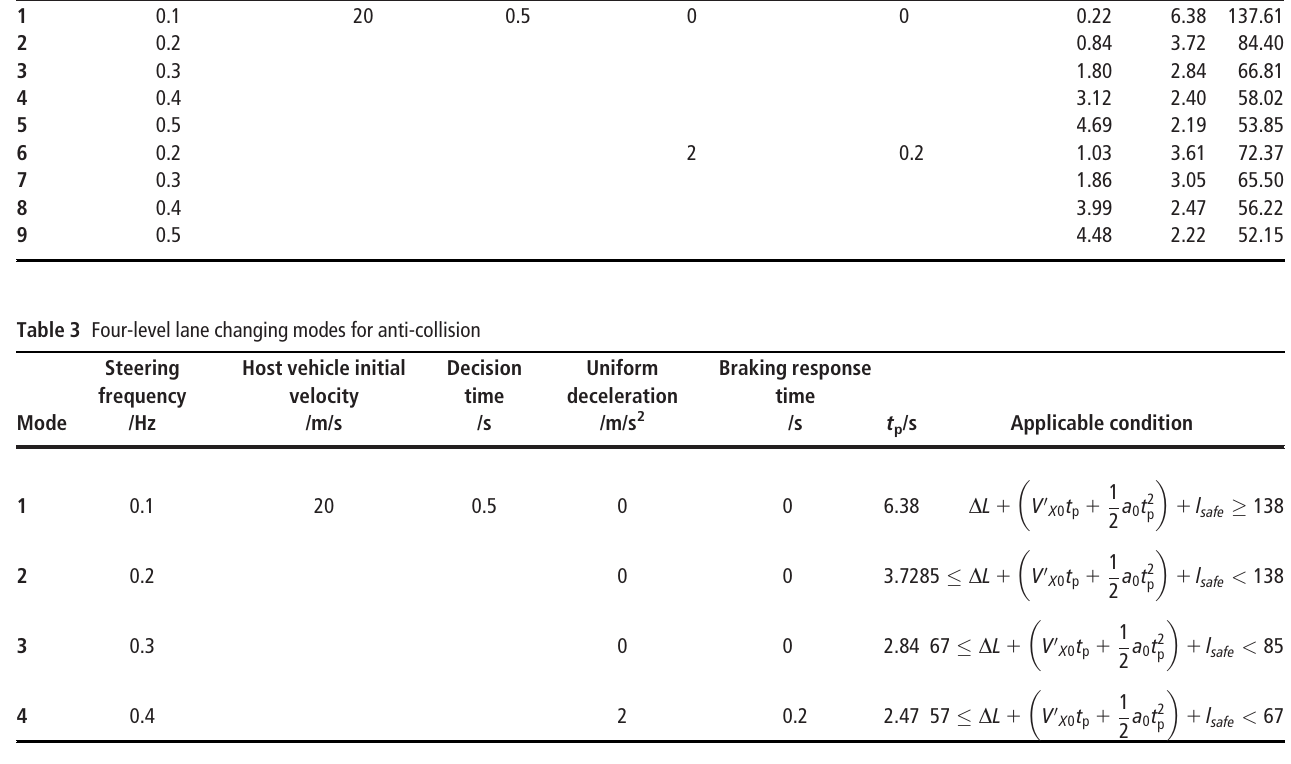
Table 2 Vehicle safe distances in different modes No. Steering frequency